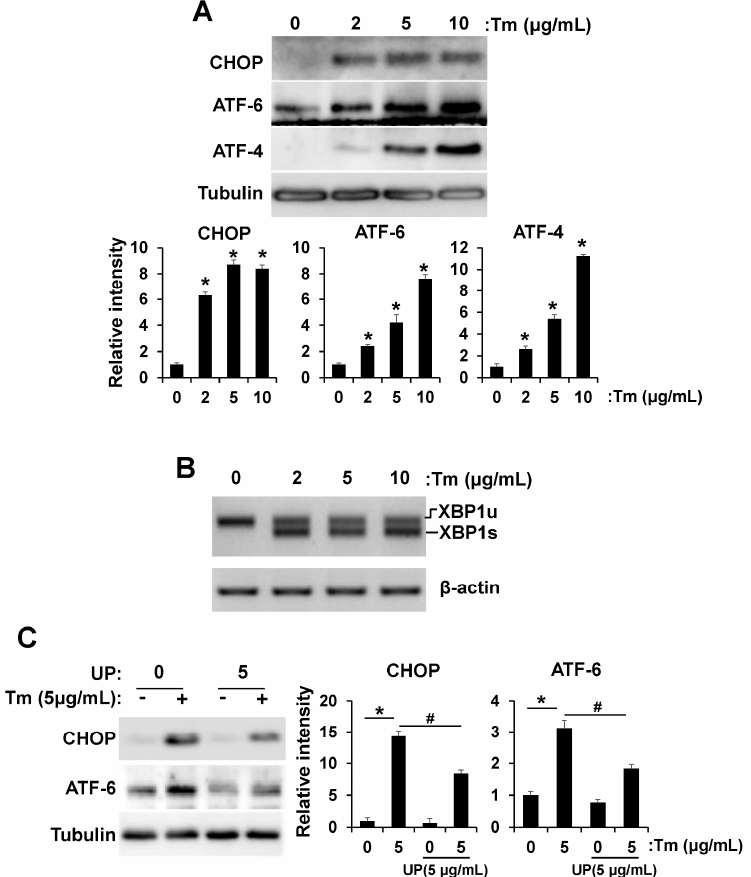
Figure 2. UP attenuates tunicamycin induced ER stress. ( A ) GT1-7 cells were treated with